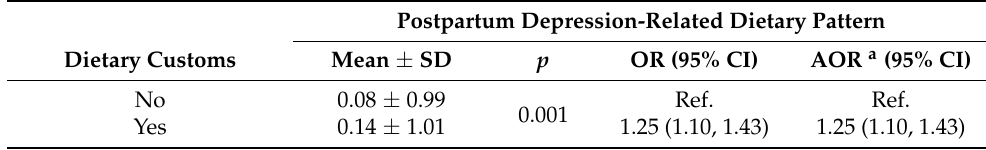
Table 3. The association between PPD-related dietary pattern score and traditional postpartum practices. Postpartum Depression-Related Dietary Pattern Dietary Customs